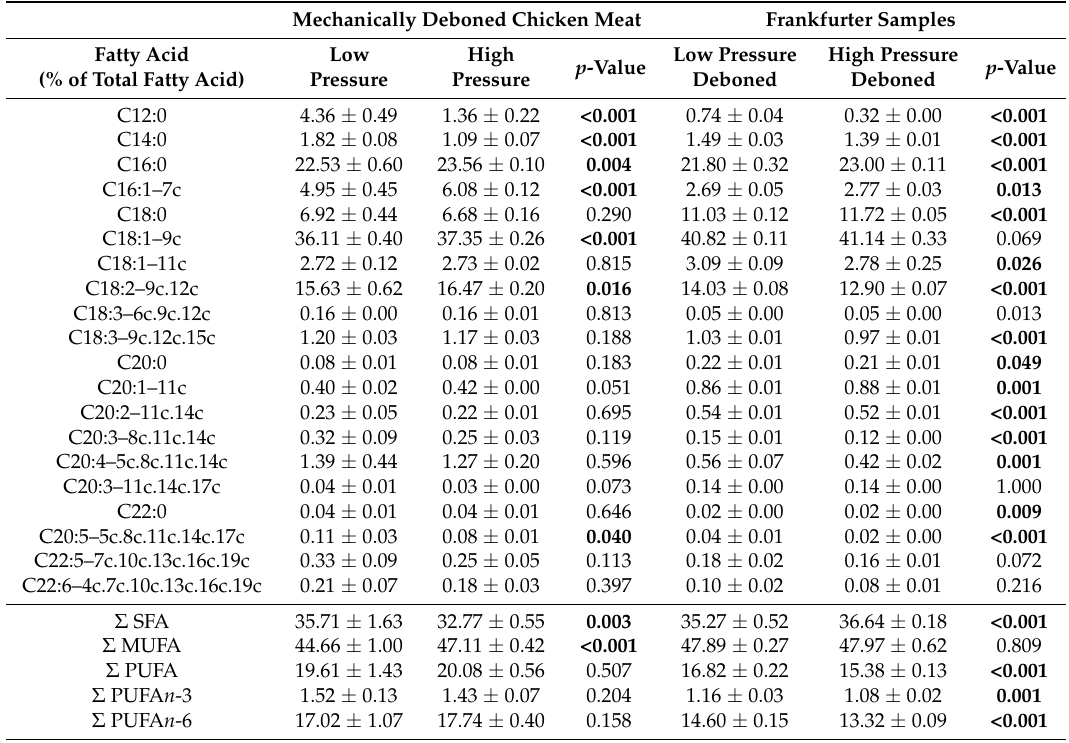
Table 1. Fatty acid composition (% of total fatty acid) in raw materials for meat production (low- and high-pressure MDCM and meat products—frankfurters (means ± SD). Mechanically Deboned Chicken Meat Frankfurter